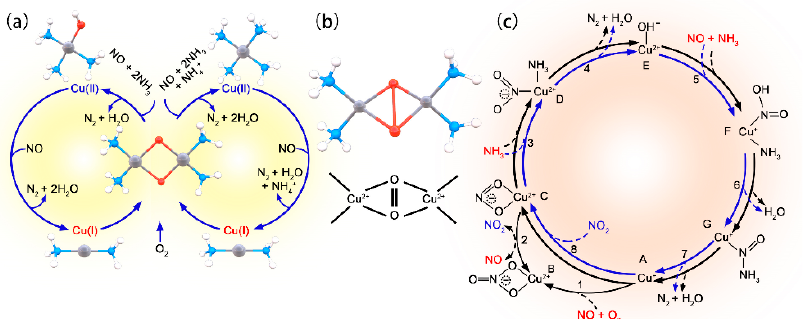
Figure 3. ( a ) Possible low-temperature SCR reaction cycle. Adapted with permission from Ref. [21]. Copyright 2017 Science. ( b ) μ - η 2 , η 2 -peroxo diamino dicopper (II) (side-on). Adapted with permission from Ref. [22]. Copyright 2020 American Chemical Society. ( c ) Possible high-temperature SCR reaction cycle. Adapted with permission from Ref. [24]. Copyright 2015 ACS Catalysts.